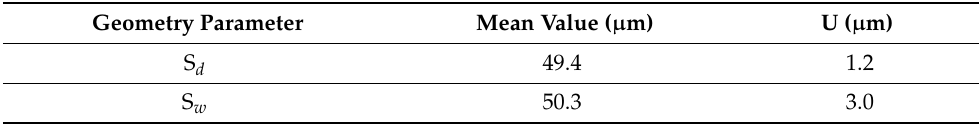
Table 2. Results of laser spot measurement.